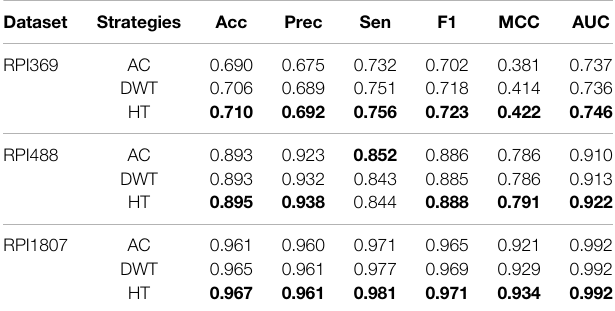
The bold values represent the higher values each column of three